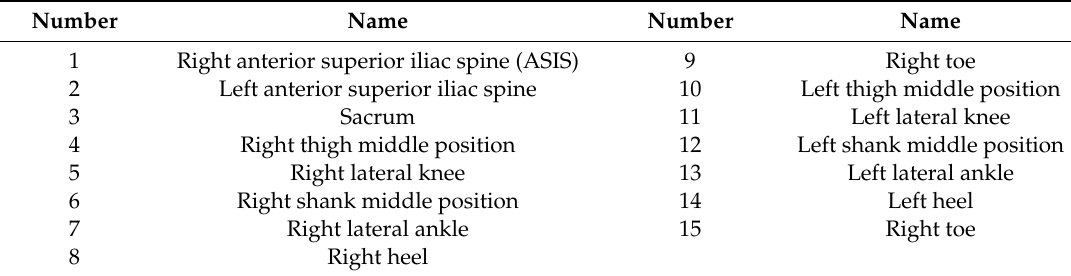
Table 2. Position names of the subjects’ 15 markers.